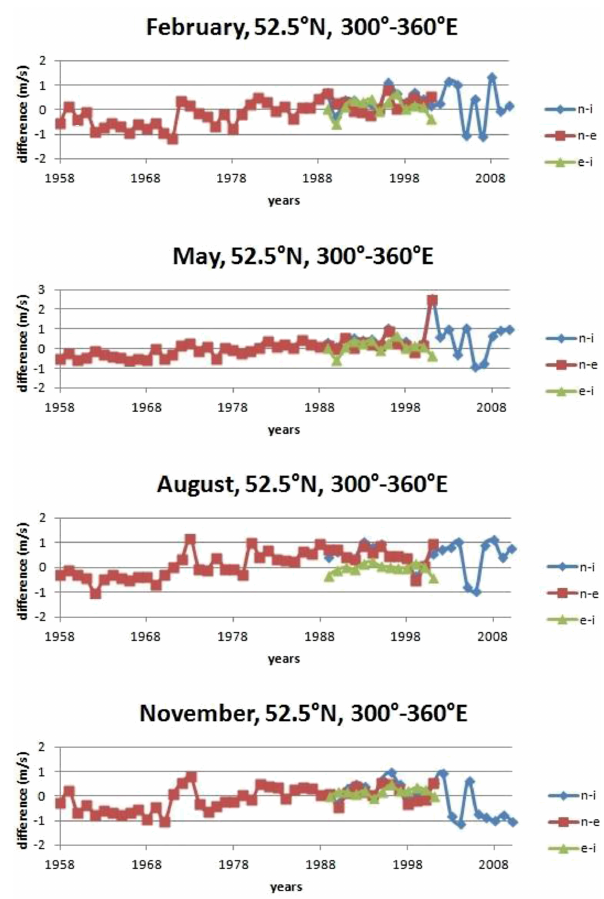
Fig. 3. Differences between reanalysis for February, May, August and November averages, 52.5 ◦ N, sector 300–360 ◦ W for 100hPa; e – ERA-40, n – NCEP/NCAR, I – ERA-Interim. Where differences overlap, only one colour is